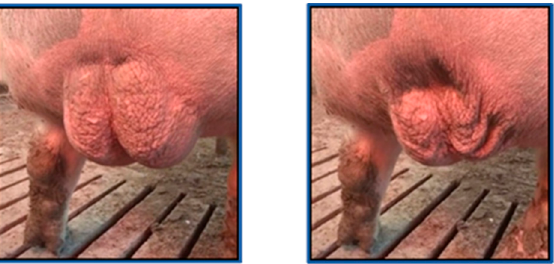
Figure 1. Video frames with relaxation ( left ) and contraction ( right ) of the boar scrotum. The size of the scrotum was measured as a percentage of pixels of the total picture.